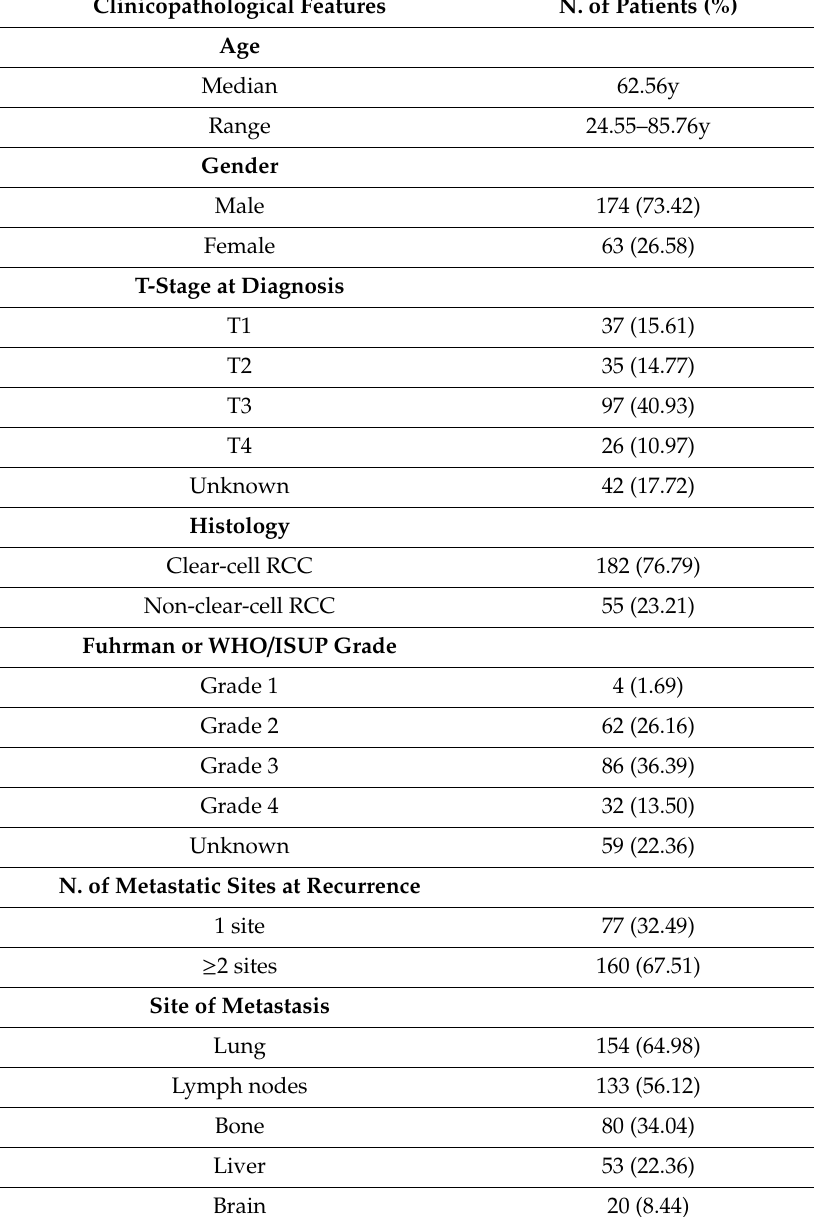
Table 1. Patients’ characteristics. Immunotherapy combinations included axitinib plus